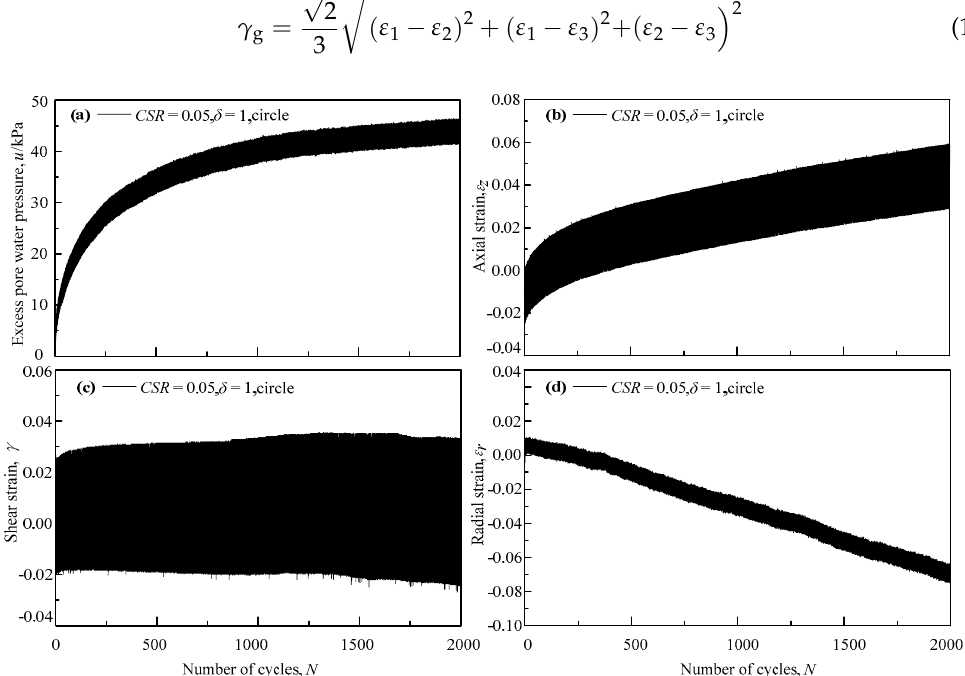
Figure 6. Typical test results of saturated silt sample under cyclic axial–torsional combined loading. ( a ) The relationship between excess pore water pressure and number of cycles; ( b ) The relationship between axial strain and number of cycles; ( c ) The relationship between shear strain and number of cycles; ( d ) The relationship between radial strain and number of cycles.